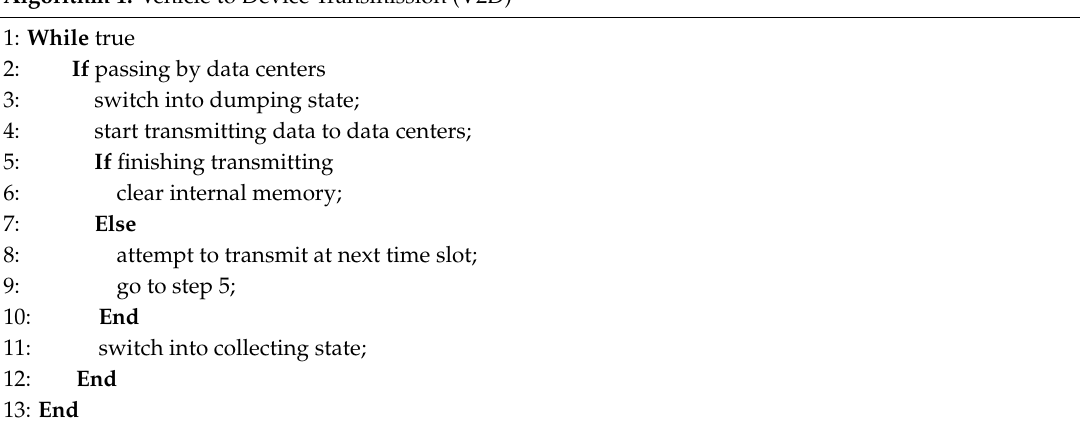
Algorithm 1: Vehicle to Device Transmission